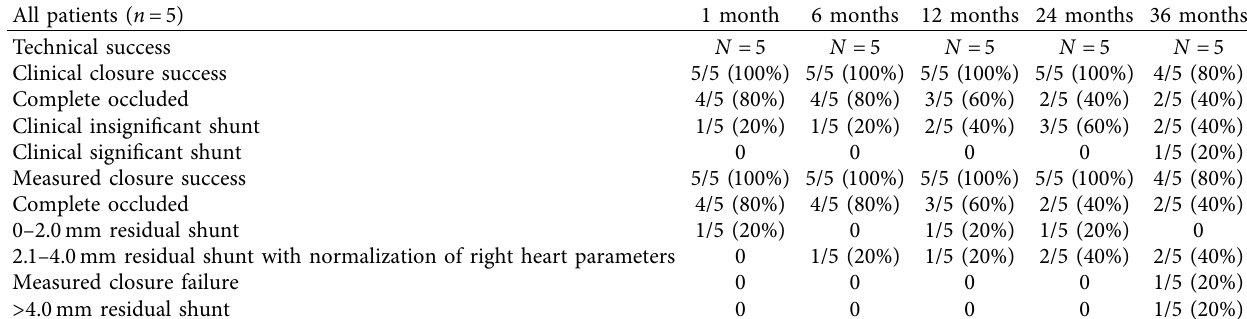
Table 3: Residual shunts and clinical